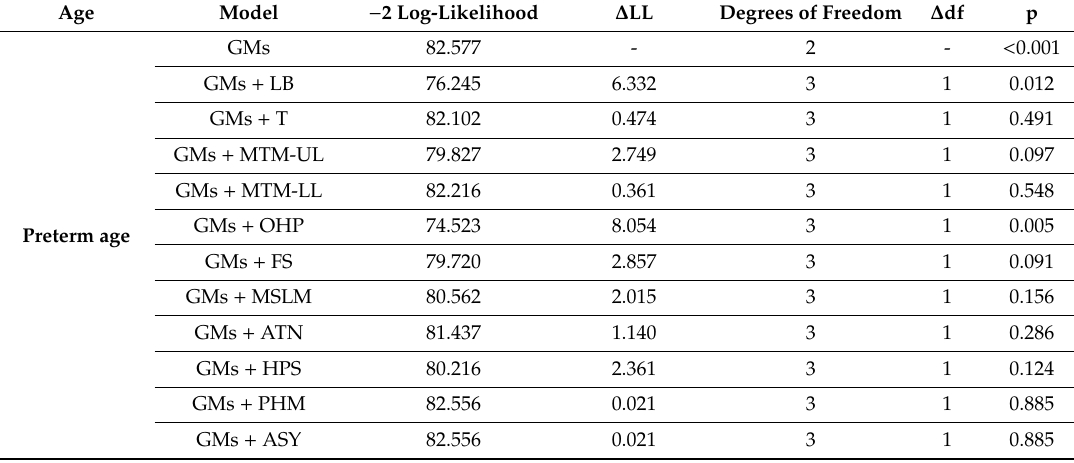
Table A1. Statistical characteristics of models used to identify individual concomitant motor and postural patterns that along with GMs are mostly associated with cerebral